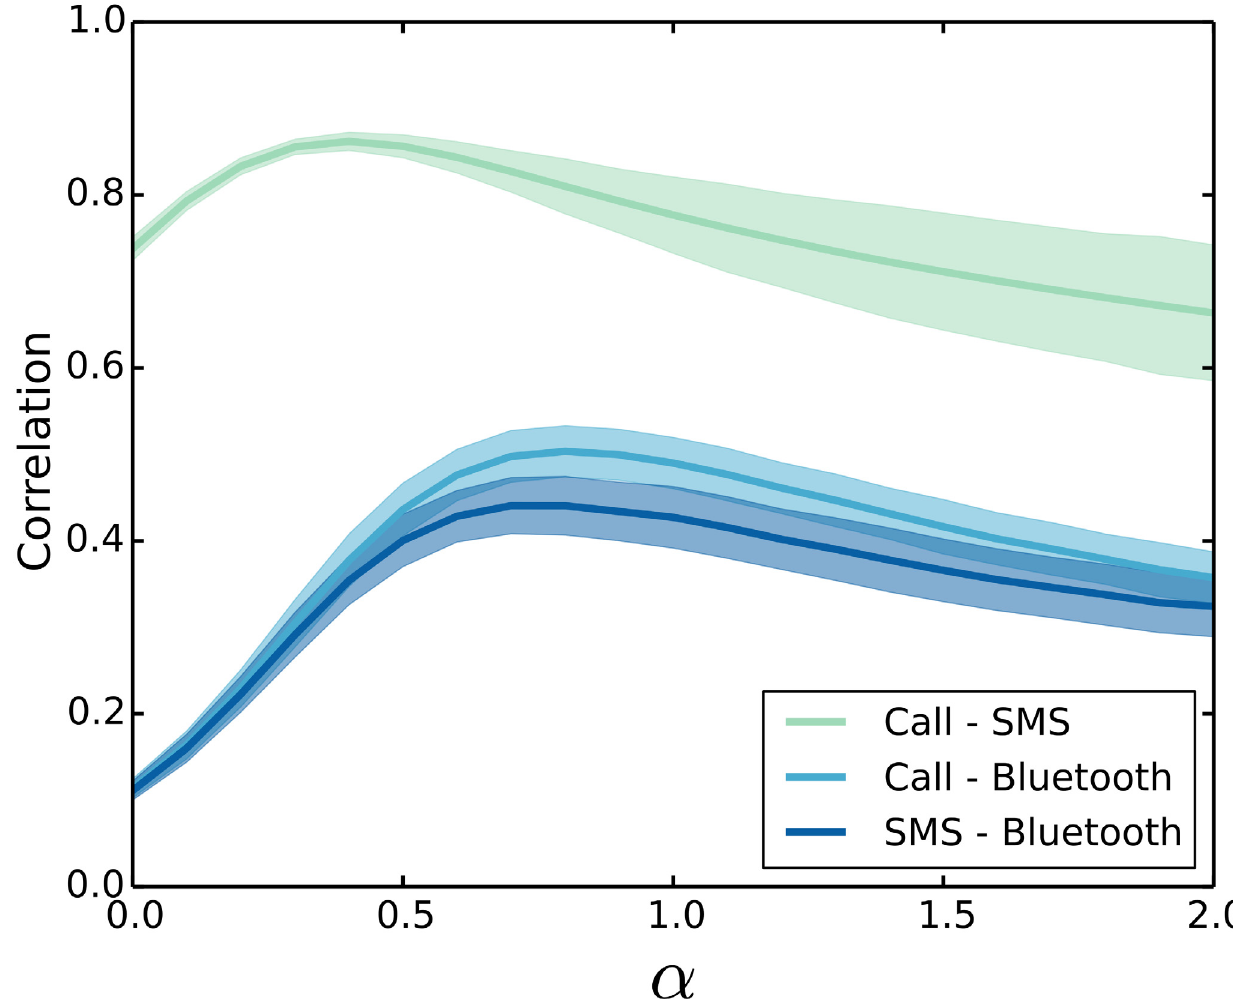
Fig 4. Overlap between layers in the multilayer social network. Based on the correlation between the link-weights, we can check the overlap between the individual layers of call, SMS, and proximity for varying values of α . We see that the multilayer features of the network changes with the link-weight exponent α and the overlap between the layers is maximal for intermediate values of α